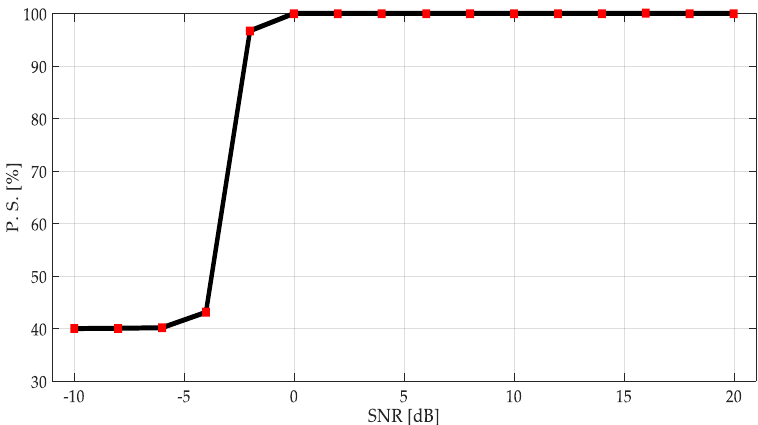
Figure 19. Percentage of success of the second methodology on simulated signals.